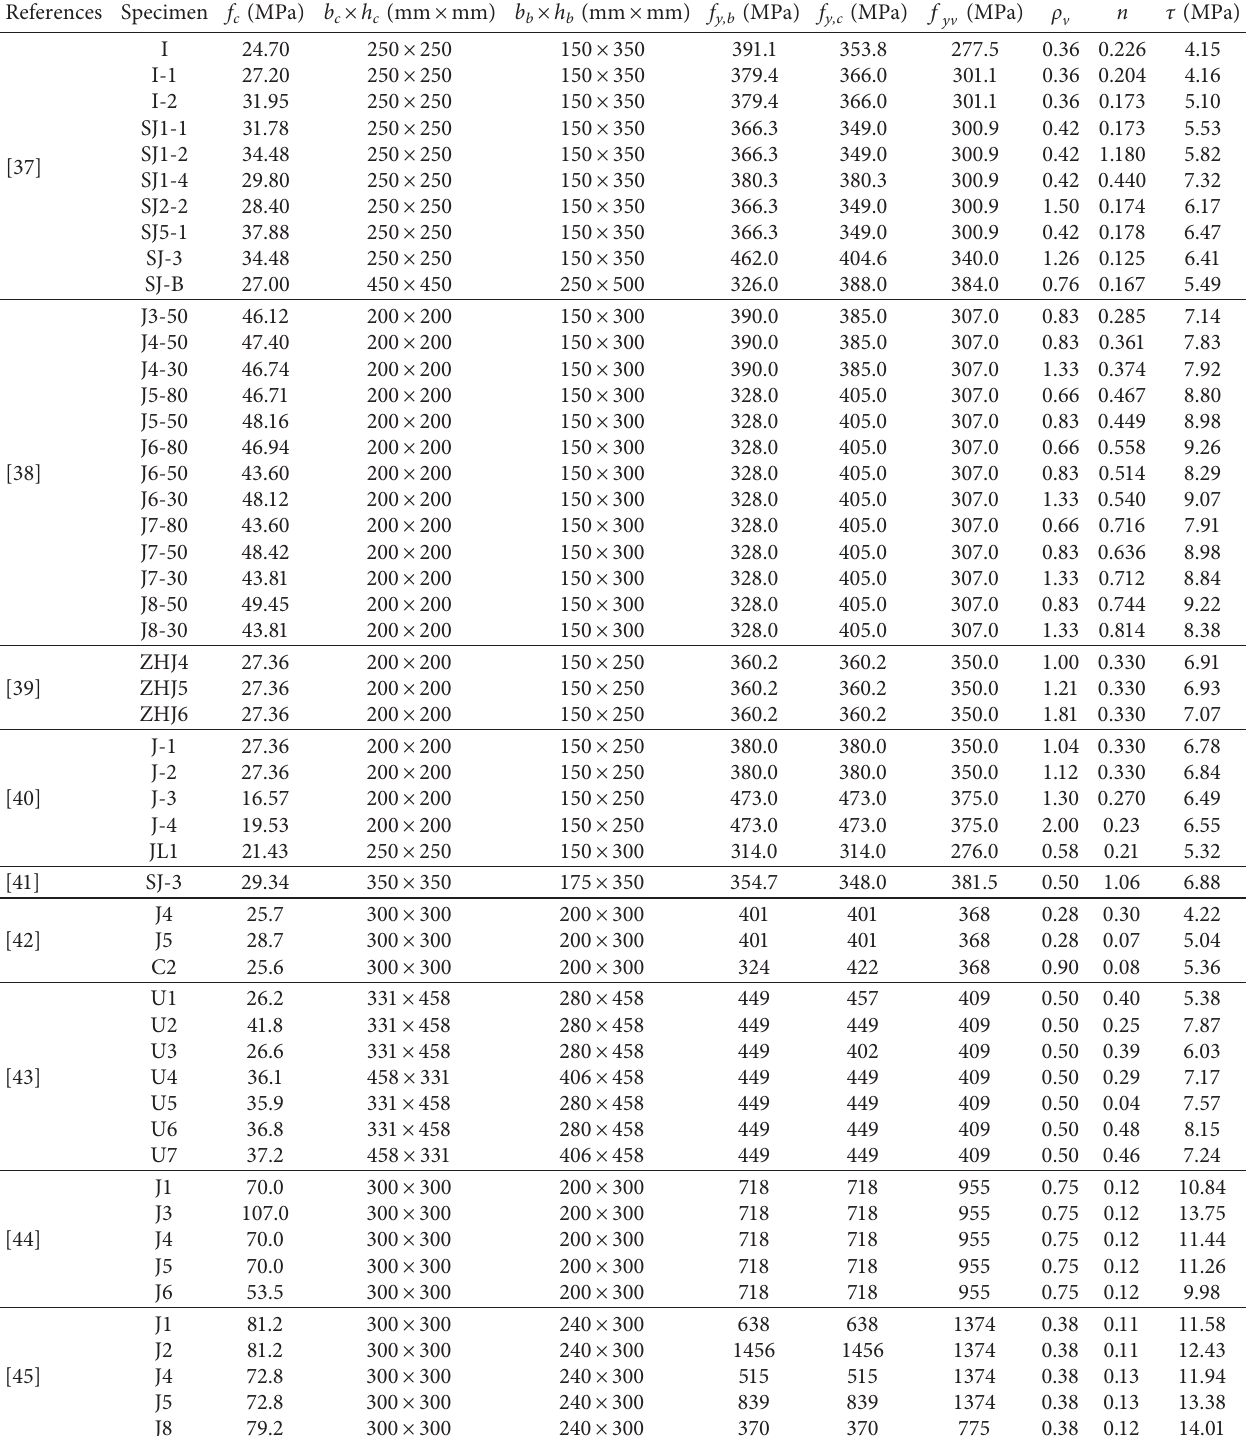
Table 3: Main data of the internal RC beam-column joint